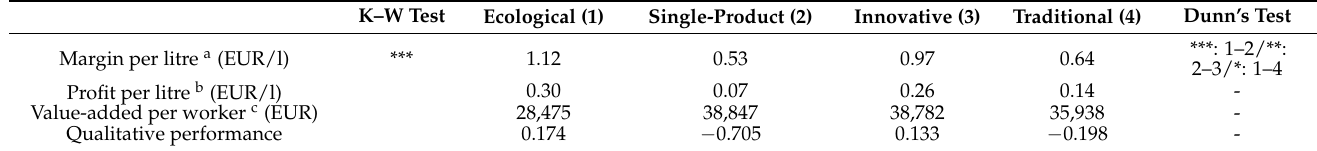
Table 7. Comparison of performance between value-creating